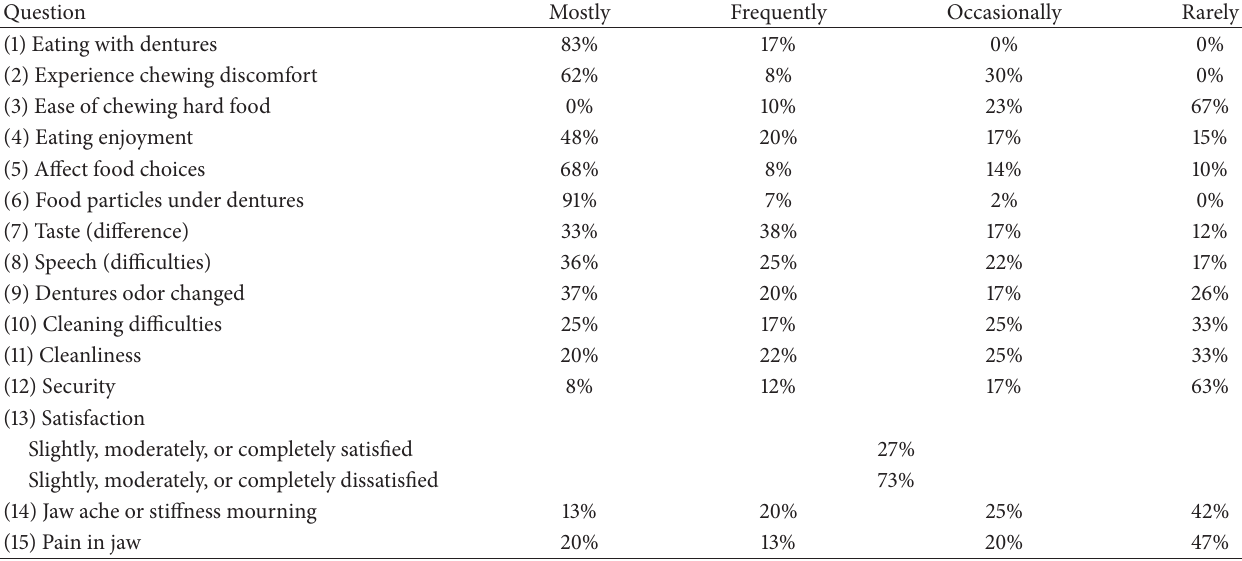
Table 1: Patients’ ( 𝑛 = 60 ) satisfaction with their original complete dentures based on their answers to Questionnaire I. Question